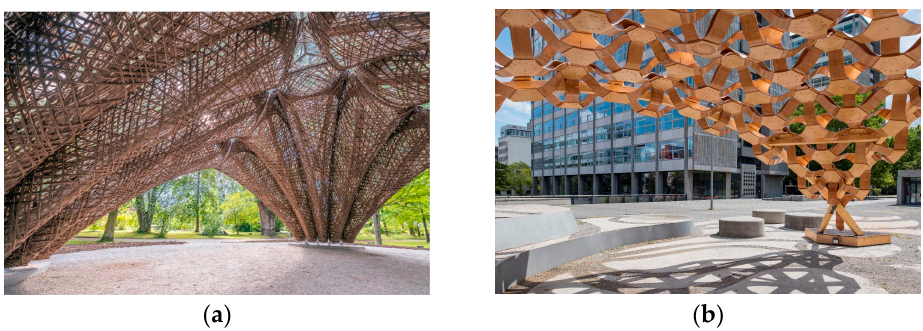
Figure 1. State-of-the-art projects that apply NFRP to structural components: ( a ) LivMatS–ICD/ITKE Research Pavilion (2020–2021). Flax fibre–polymer composite used in segmented shell structure [15]; ( b ) BioMat Pavilion 2018. Segmented shell structure made from lignocellulosic flexible core reinforced by timber veneer layers (vacuum-formed) [9].